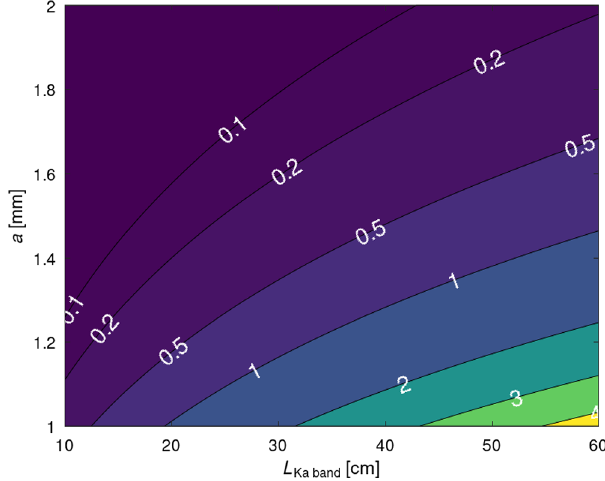
FIG. 2. Example of start-to-end tracking in CompactLight, obtained with the code T rack1 D